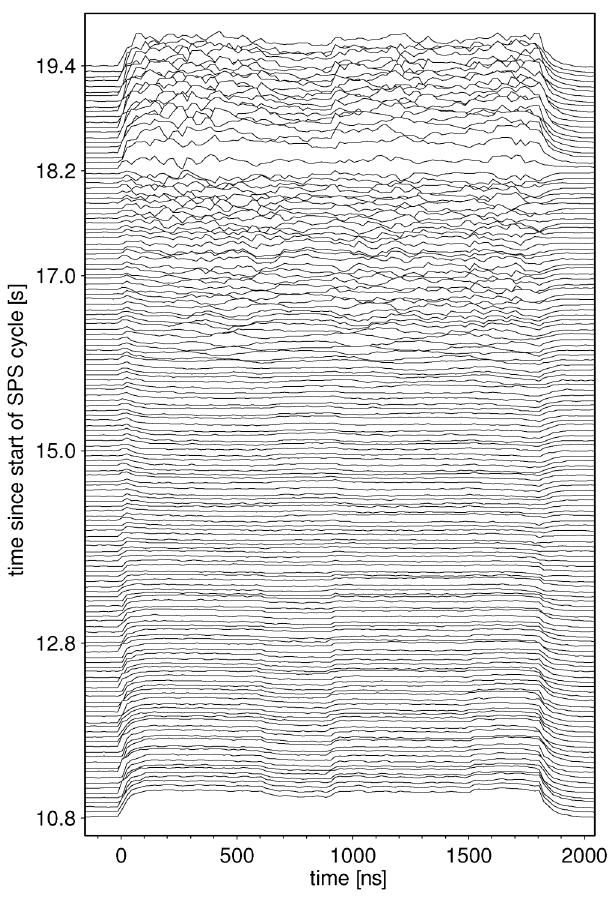
FIG. 7. Mountain range measurement of the pickup signal of the longitudinal damper. The 800 MHz system and the rf AM are switched off.